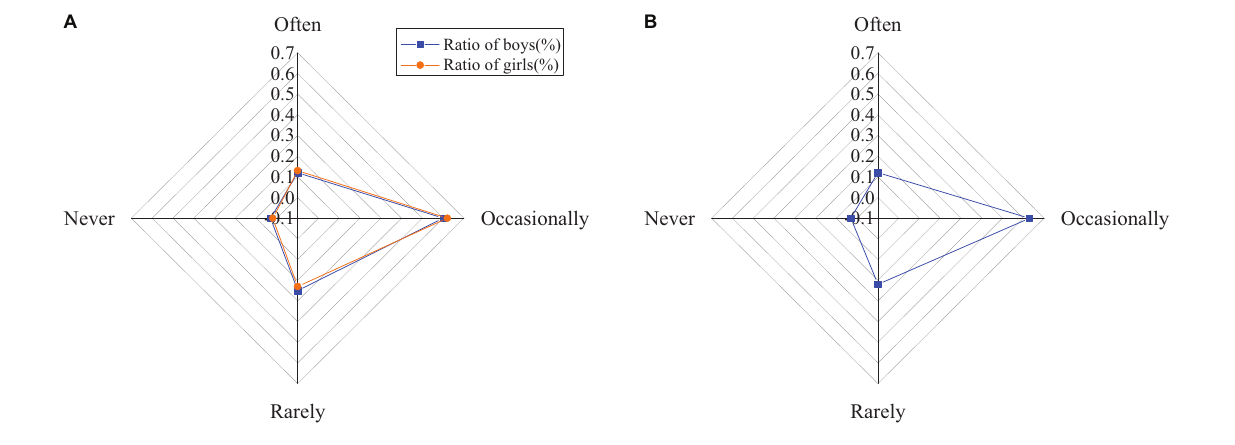
Frontiers in Psychology |